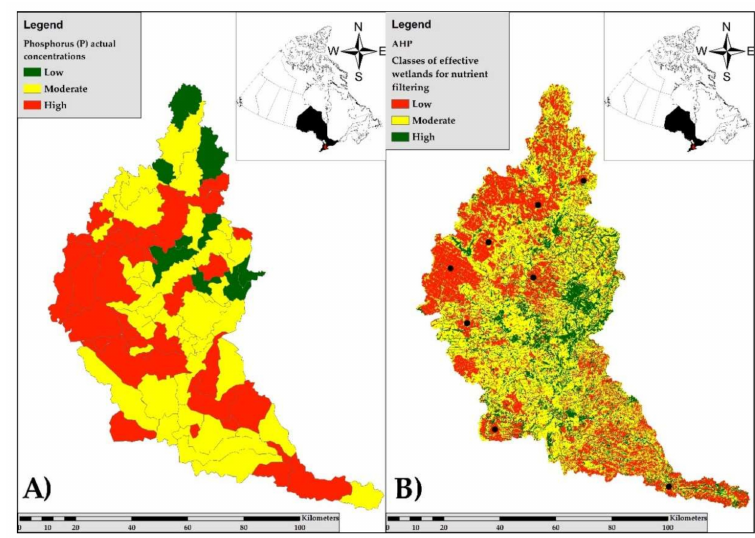
Figure 4. ( A ) Phosphorus (P) actual concentrations in the watershed; ( B ) Areas that could support effective wetlands for nutrient filtering (black dots represent common areas within the red classes of ( A , B